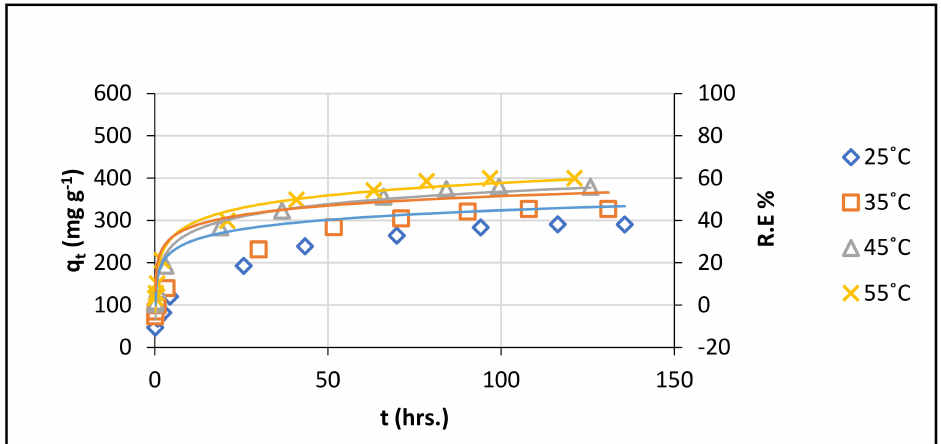
Figure 6. Impact of temperature on adsorption of CR dye onto UCs (Experimental conditions: 50 mg of adsorbent, 50 mL of dye solution (600 mg L − 1 ) and pH